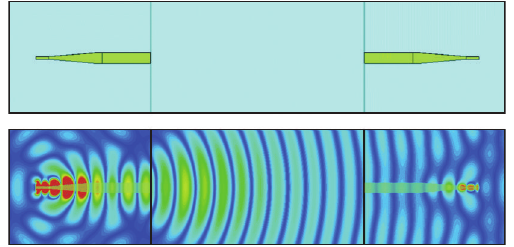
Figure 10: Optical wireless link between nanoantennas embedded in glass substrate and corresponding radiated E-field. Distance between nanoantennas is 4 µ m, frequency is 300THz, and propa- gation medium is glass.